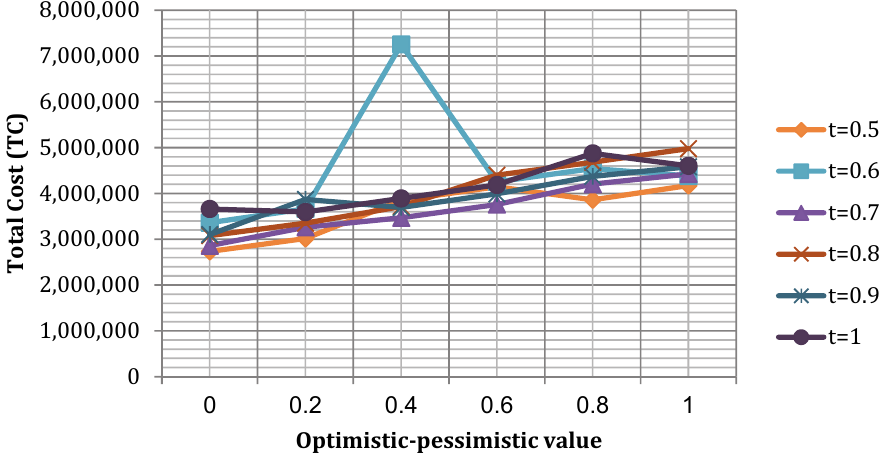
Fig. 2. Total costs based on the different optimistic-pessimistic values and confidence levels for LAM corresponding equivalent single objective